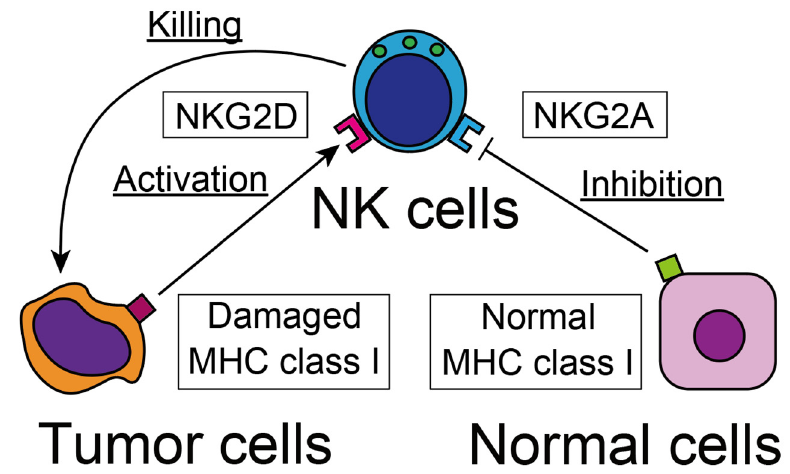
Figure 1. NK cells recognize tumor cells with their activating and inhibitory receptors. Tumor cells that have lost standard MHC class I are the best targets for NK cells.